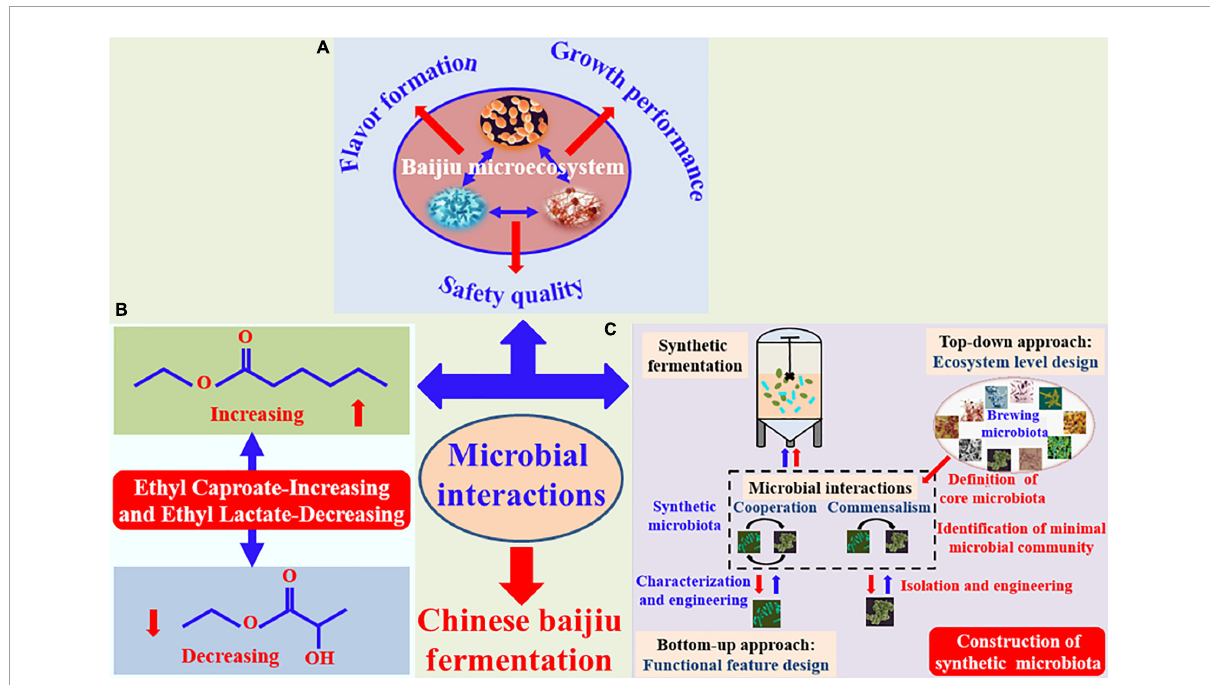
FIGURE1 Effect of microbial interactions on regulation of growth and flavor metabolism (A) and “Ethyl Caproate-Increasing and Ethyl Lactate-Decreasing” (B) , as well as construction of synthetic microbiota (“top-down” approach was red arrows, and “bottom-up” approach was blue arrows) (C) in Chinese baijiu fermentation